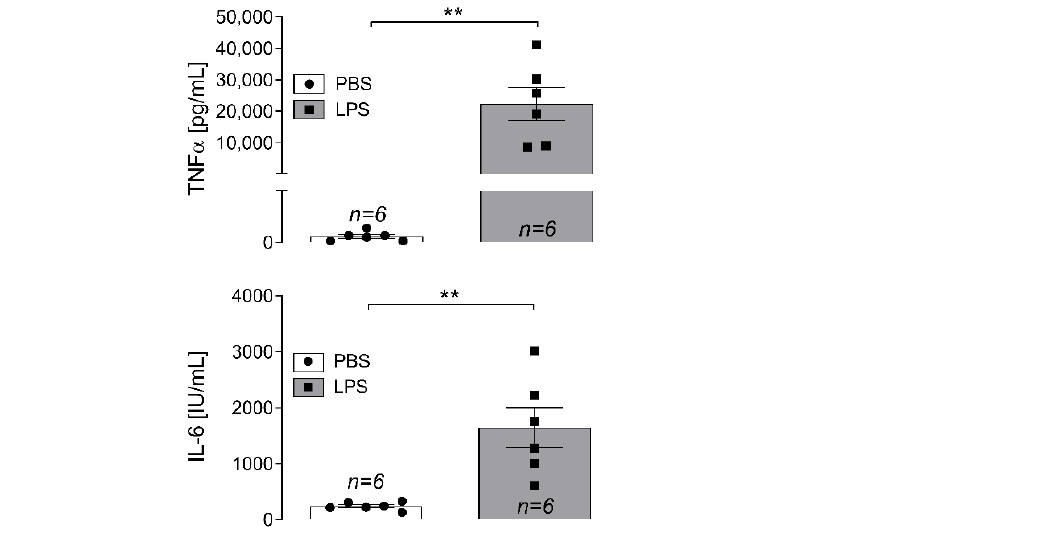
Figure 1. Circulating plasma cytokine levels in rats treated with PBS (controls) or LPS. Rats treated with LPS (100 µg/kg, i.p.) show higher plasma concentrations of TNFα ( A ) and IL-6 ( B ) than PBS- treated controls 3 hours after injection. Cytokine measurements were performed by means of specific bioassays. Bars represent the mean ± SEM with symbols indicating results of single animals ( n = 6). **: p < 0.01. TNFα: tumor necrosis factor alpha, IL -6: interleukin-6, PBS: phosphate buffered saline, LPS: lipopolysaccharide.